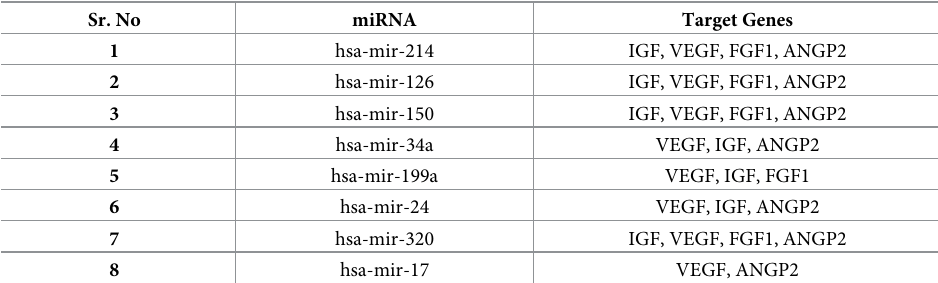
Table 1. Selected miRNAs based on their targets.